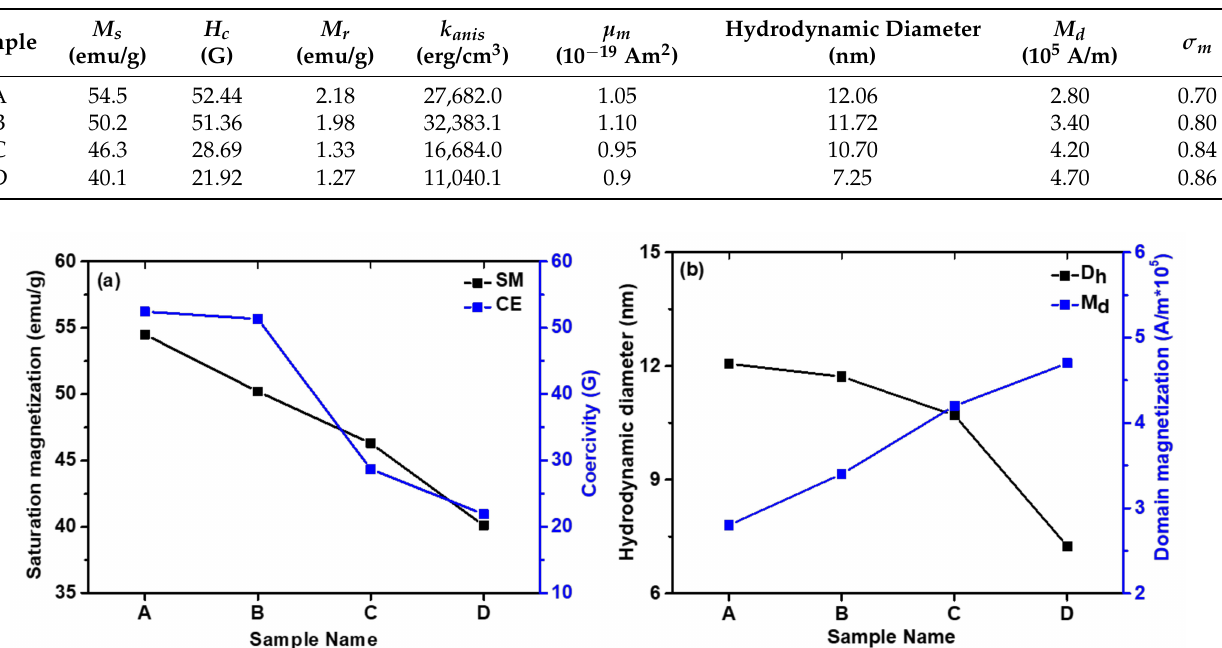
Figure 9. Variation of: ( a ) saturation magnetization and coercivity; ( b ) hydrodynamic diameter and domain magnetization for different AMF